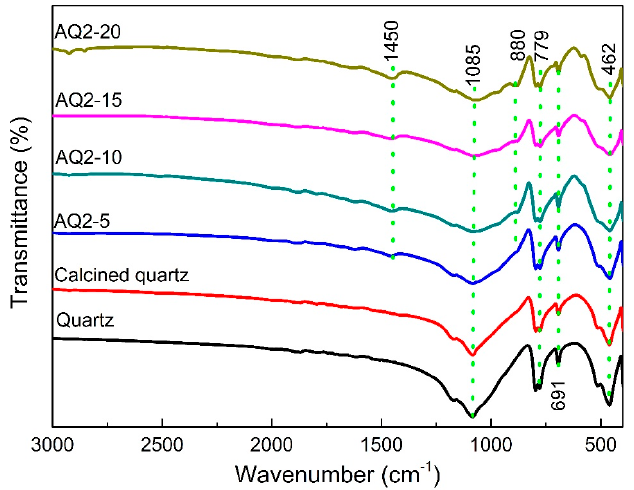
Figure 4. FTIR spectra of quartz, calcined quartz and quartz-2 activated with various content of NaOH.